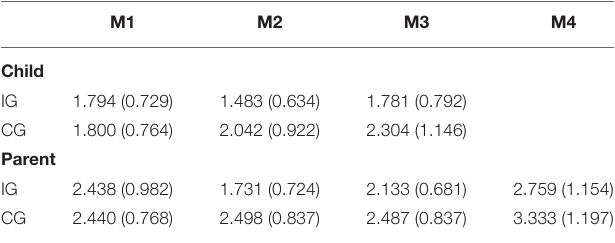
TABLE 5 | M (SD) of the mood ratings at the respective measurement points. M1